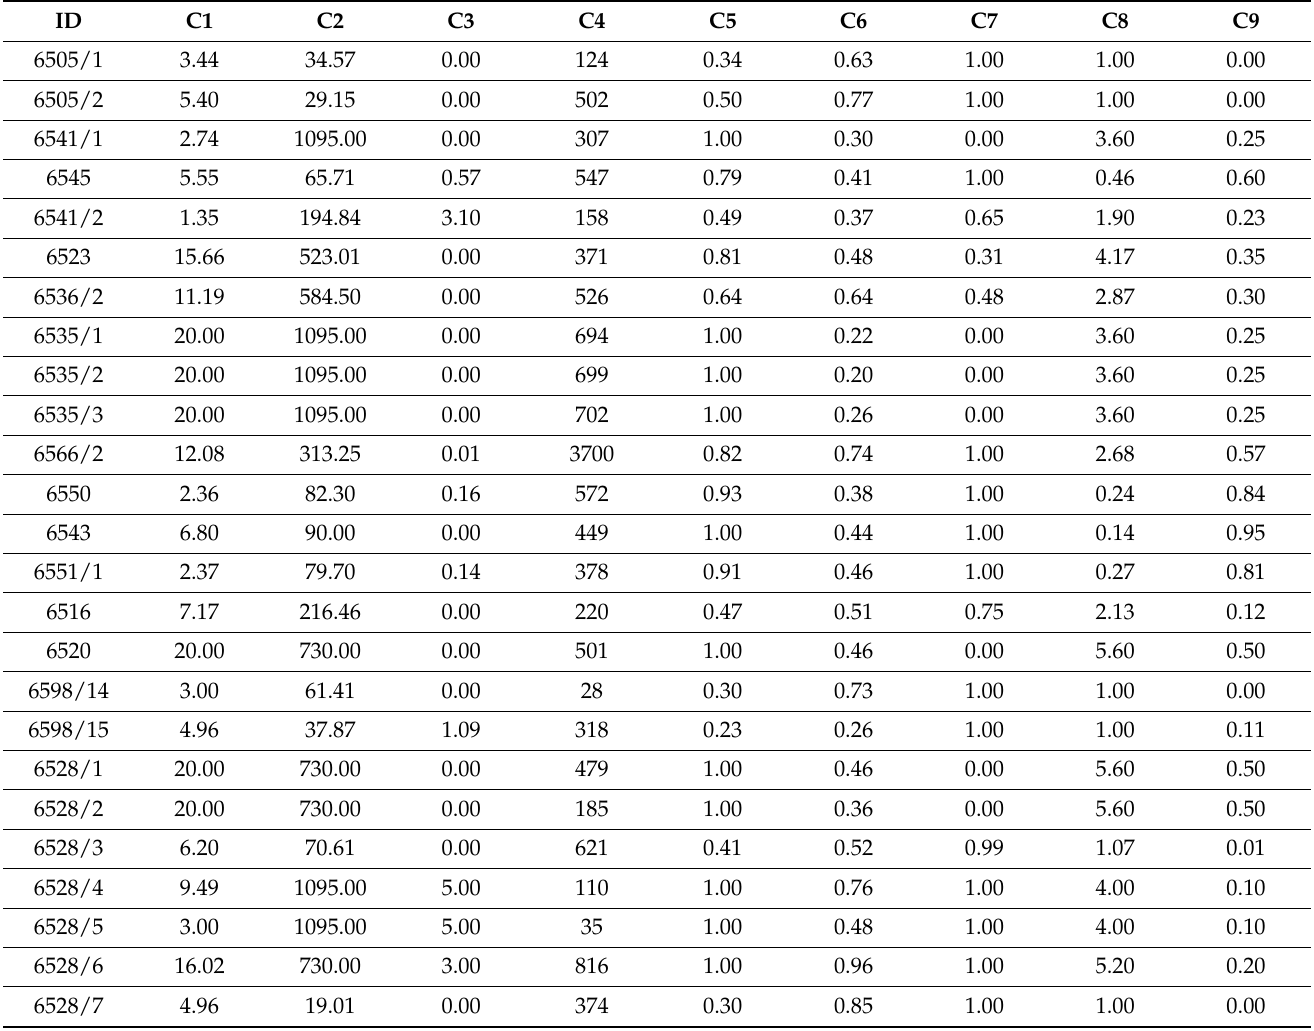
Table A2. The results of the evaluation of cadastral parcels according to defined criteria (extended version of Table